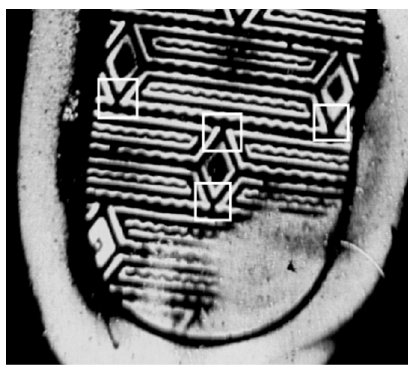
Figure 8. Periodic patterns that are labeled with white rectangles, and they are usually mistaken for individual identifying characteristic.